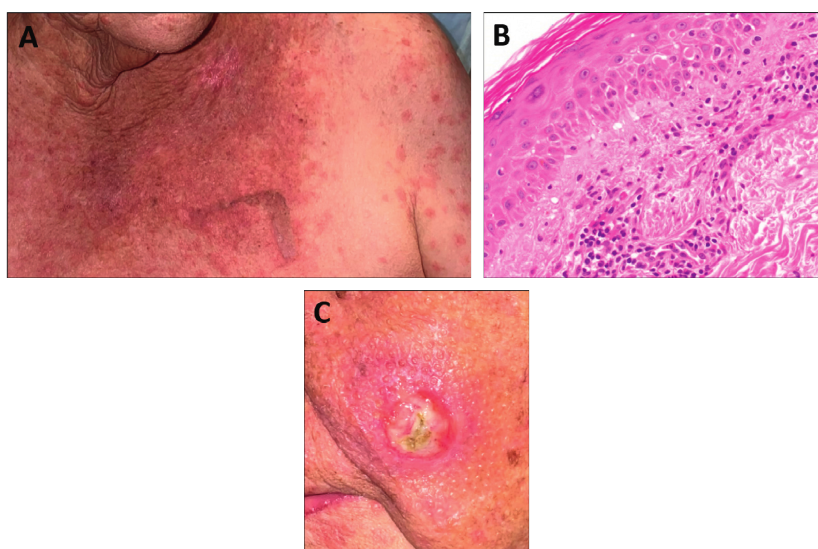
Figure 5: (a) Truncal eruption of pink macules and thin papules with minimal overlying scale coalescing centrally at the upper back and chest, with extension to the rest of torso and upper extremities, hospital day 4. (b) Biopsy revealed an interface dermatitis with dyskeratosis and superficial perivascular lymphocytic infiltrate. (c) Primary lesion to the left cheek showing significant recession on clinical examination after bimodality therapy, hospital day 4.